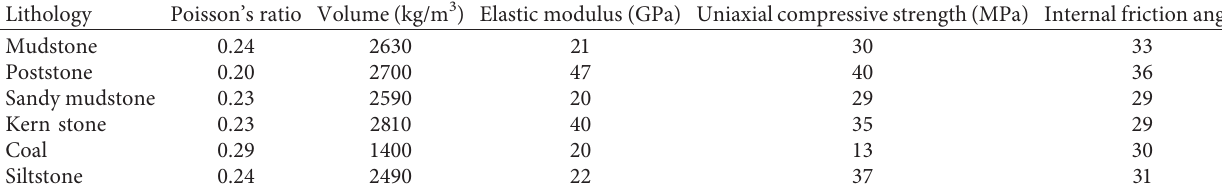
Figure 6: Breaking of the key stratum in the upslope mining. (a) 1 − 2 upper coal seam. (b) 1 − 2 coal seam. Table 3: Physical and mechanical properties of borehole strata.